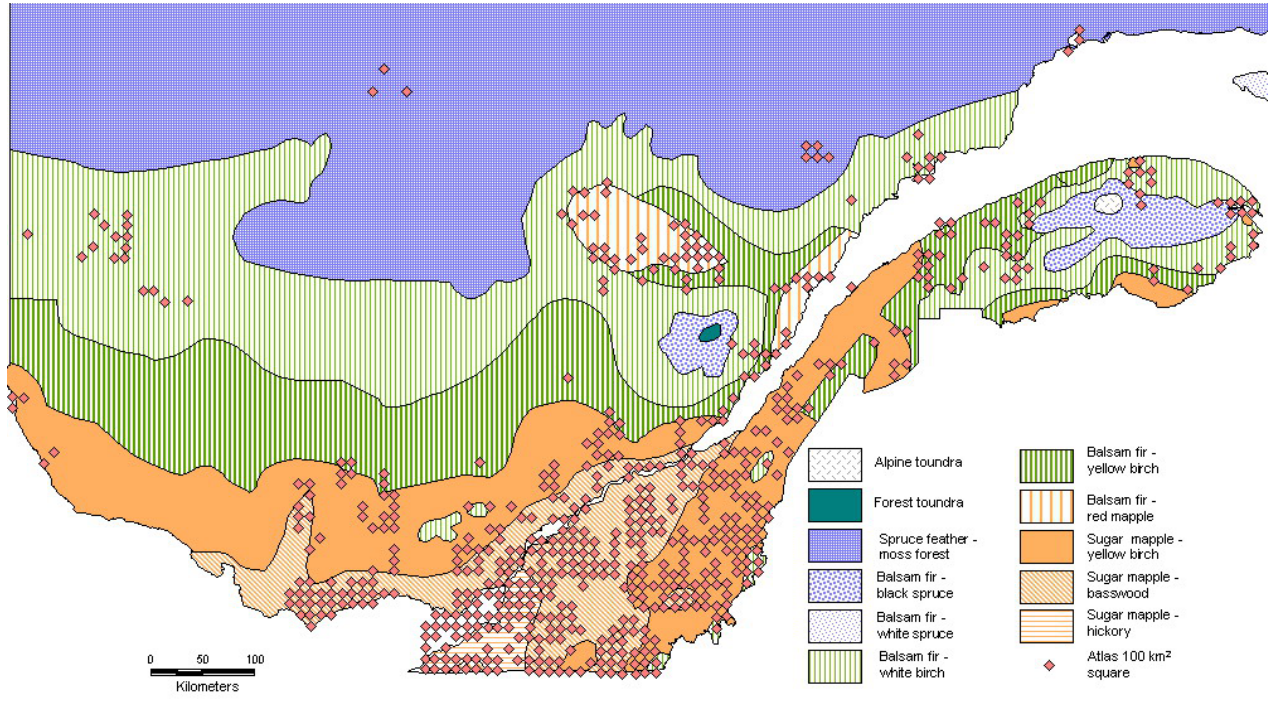
Fig. 1 . Layout of the 601 bird atlas squares selected for the analysis according to the major vegetation zones of southern